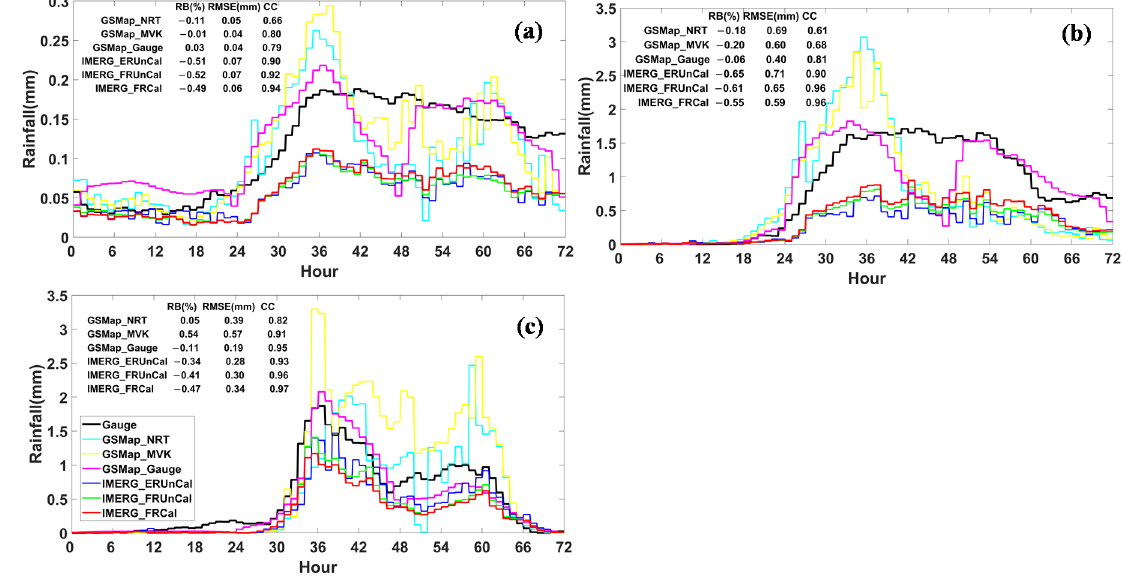
Figure 7. Area-mean hourly rainfall over ( a ) mainland China and the rainfall centers in ( b ) southern China and ( c ) eastern China.